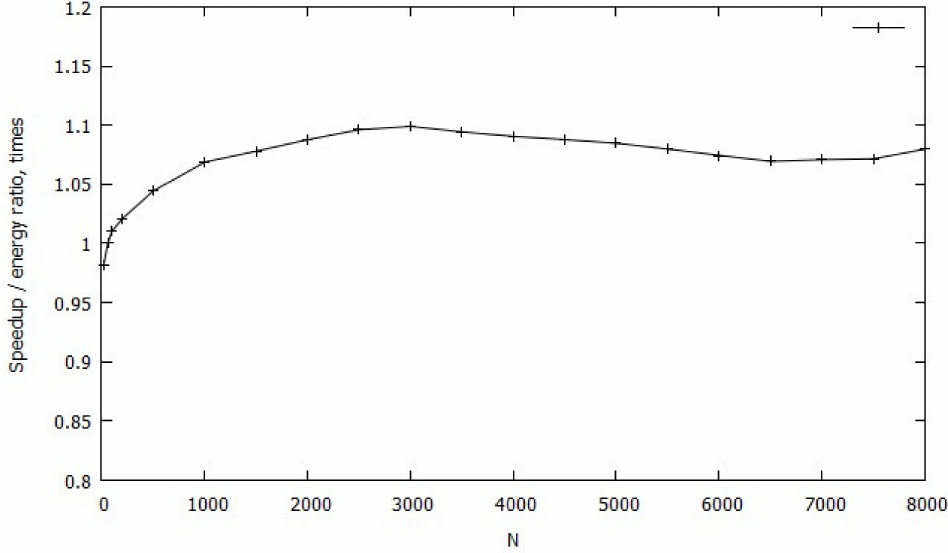
Figure 12. The ratio of speedup to the decreasing of energy consumption for a single-pass